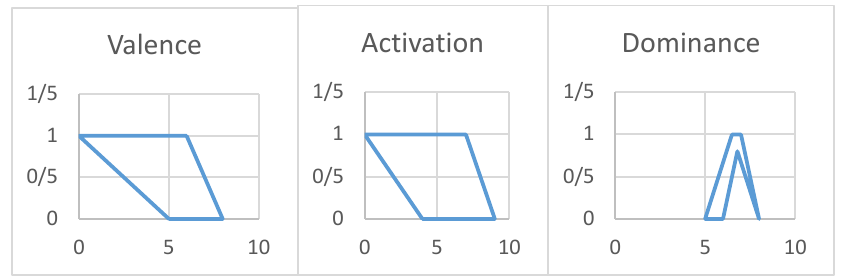
Fig. 4. The FOU of Iwe (Anger) for dimensions valence, activation and dominance.